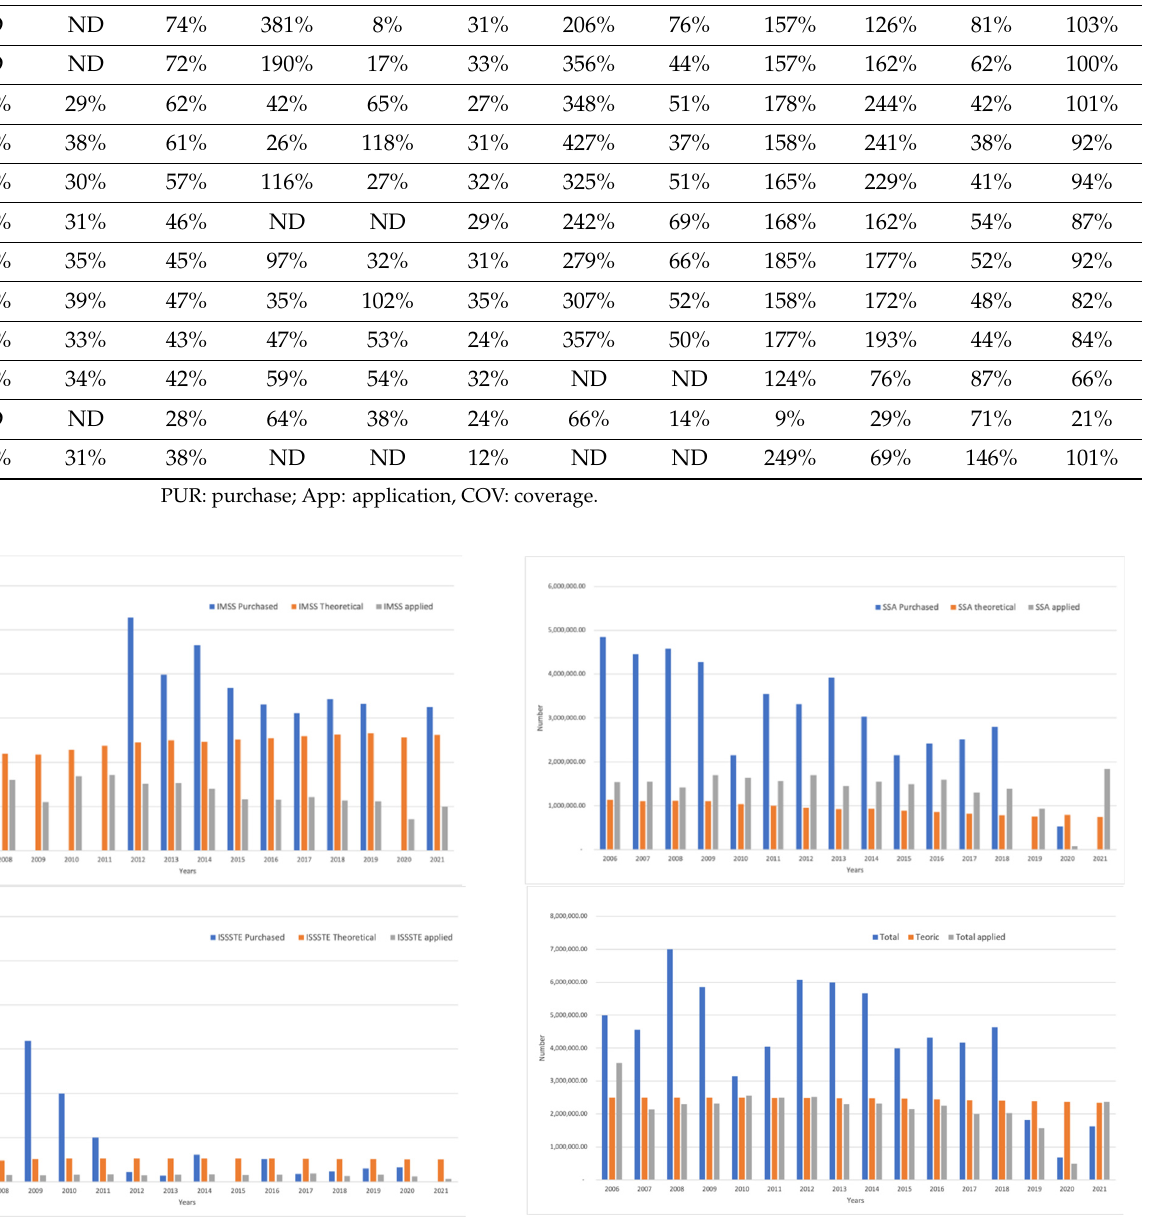
Figure 3. Comparison between total acquired BCG vaccines, theoretical target population and application as reported by institution.